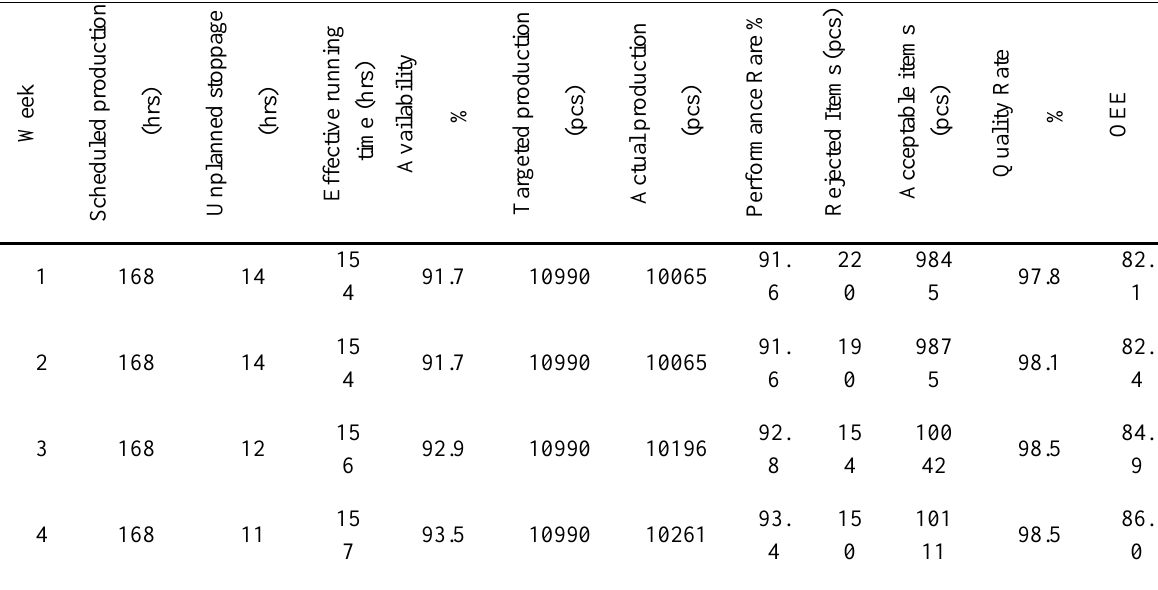
Table 9. Final OEE calculation.